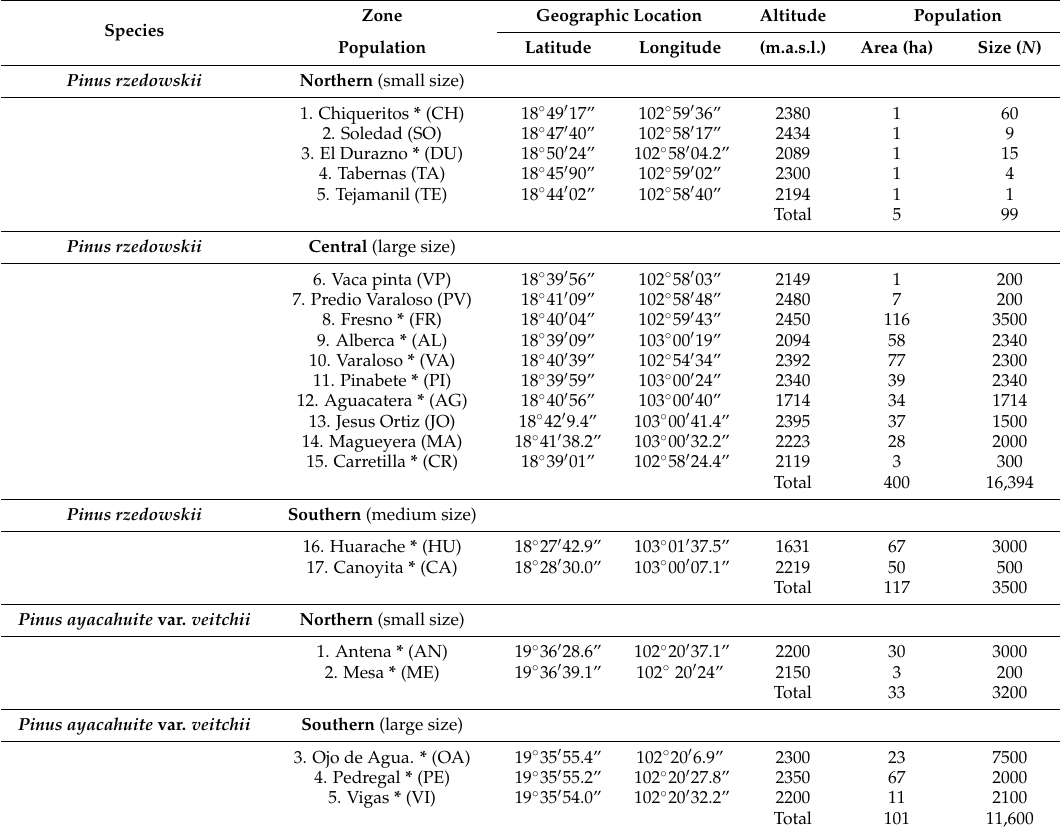
Table 1. General data regarding the geographical locations of Pinus rzedowskii and P. ayacahuite var. veitchii populations in Michoacán,